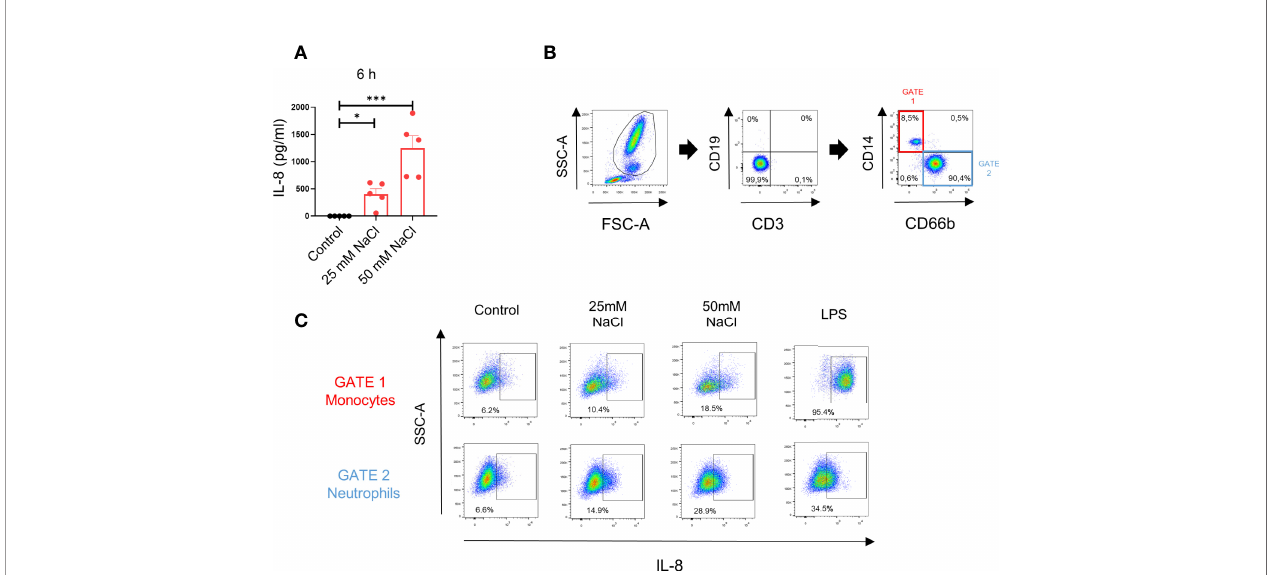
FIGURE 2 | High salt induces IL-8 production in whole blood samples. (A) Whole blood samples (200 m l) supplemented or not with NaCl (25 mM and 50 mM) were incubated for 6 h at 37°C. Then, IL-8 in the plasma fraction was evaluated by ELISA. Results are expressed as the mean ± SE from 5 experiments. (B) Gating strategy used to evaluate the production of IL-8 by neutrophils and monocytes in whole blood samples. (C) Whole blood samples (200 m l) supplemented or not with NaCl (25 mM or 50 mM) or LPS (100 ng/ml) were cultured for 8 h (the last 4 h of incubation was performed in the presence of the Golgi transport inhibitor BFA 10 m g/ml), and IL-8 production was analyzed by intracellular staining and fl ow cytometry in the gate of neutrophils and monocytes. A representative experiment (n=3) is shown. * P <.05, and *** P